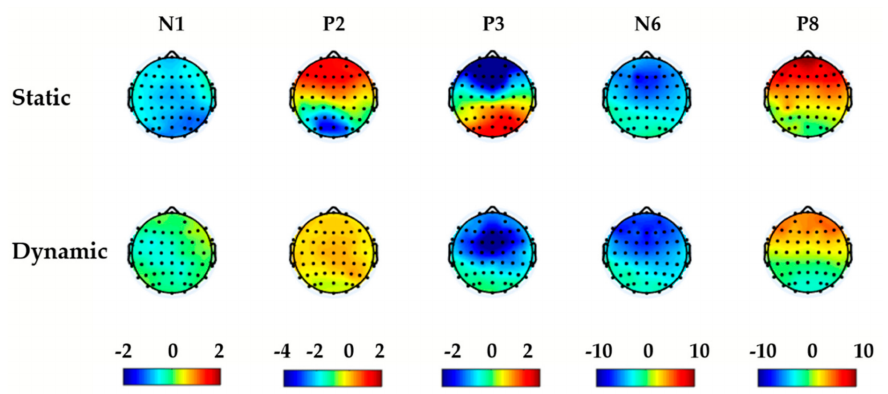
Figure 5. Scalp topographical maps of the di ff erence values between error and correctness (error minus correctness) under static and dynamic stimulations, for each component (N1, P2, P3, N6, P8).